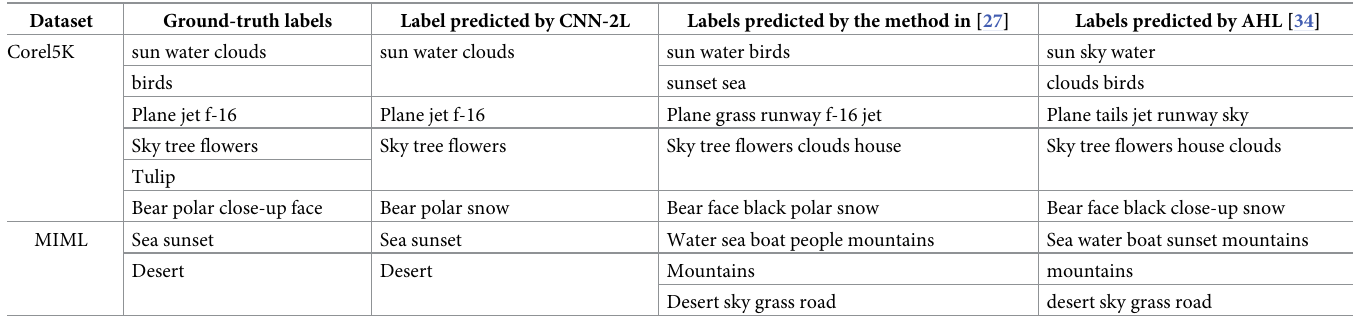
Table 4. Comparison of image annotation methods in various experiments.